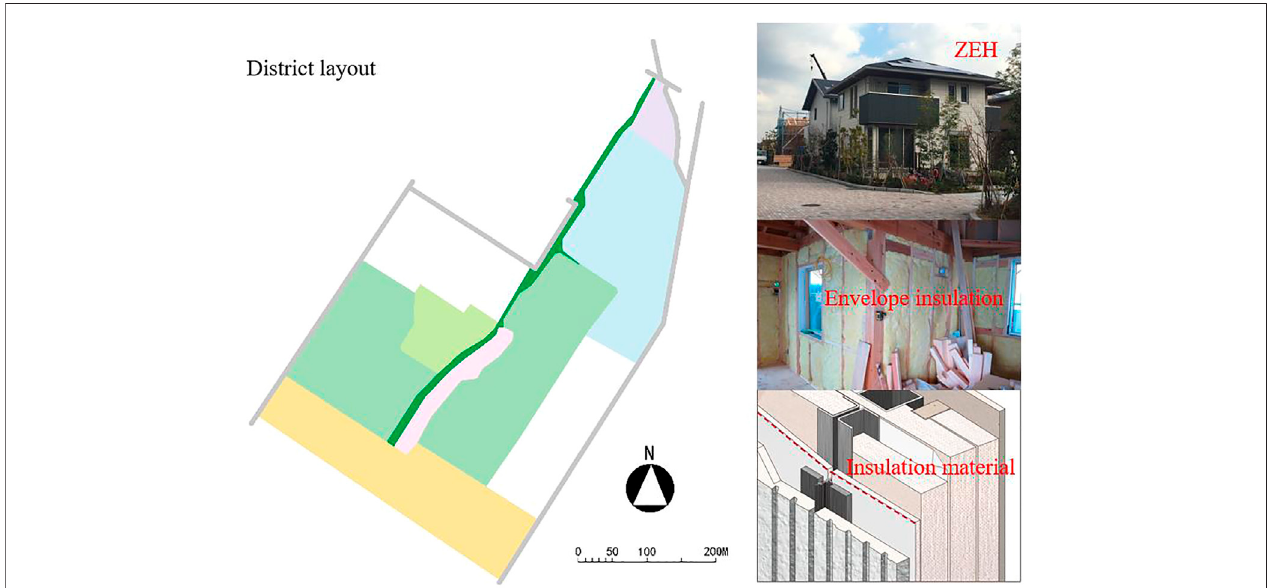
Figure 2 . First, more than 20% reduction of primary energy